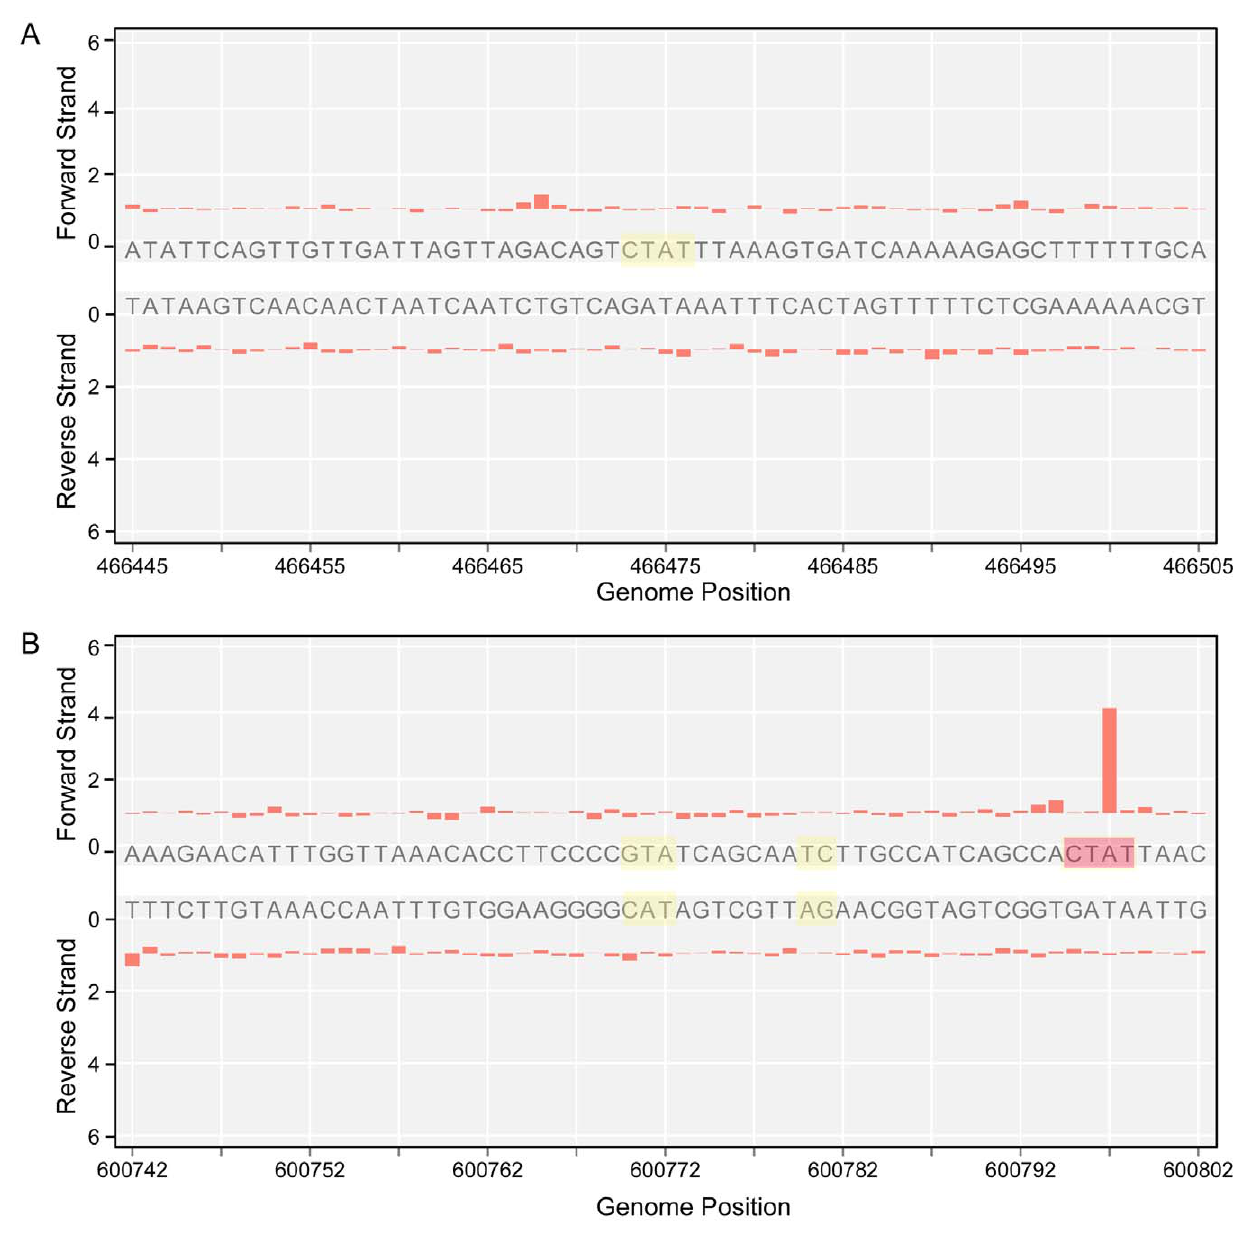
Figure 4. Unmethylated sites. A) IPD ratio plot of a 5 9 -CT A T-3 9 site not detected as methylated (shadowed in yellow). B) IPD ratio plot of an unmethylated 5 9 -G A N 7 TAY-3 9 /3 9 -CTN 7 A TR-5 9 motif (shadowed in yellow). For comparison of signal intensity, a methylated 5 9 -CT A T-3 9 is also shown in the bottom plot (shadowed in red).